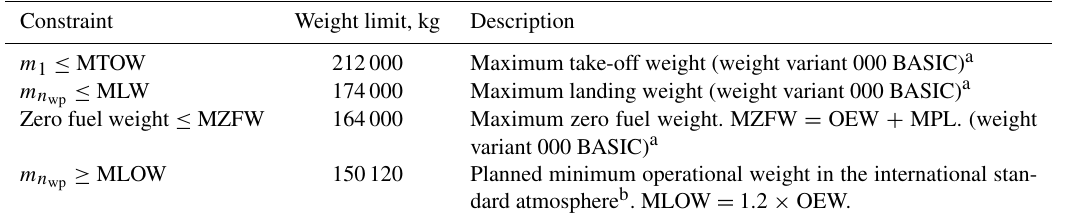
Table 14. Constraints from the structural weight limits (MTOW, MLW and MZFW) and one specified weight limit (MLOW) of A330-301 aircraft. m 1 and m n correspond to the aircraft weight at the first and last waypoints, respectively. OEW and MPL are given in Table wp